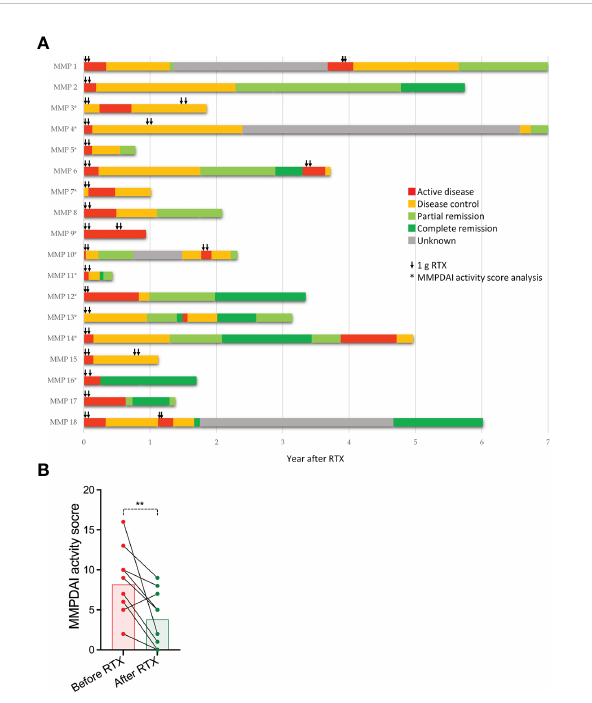
FIGURE 1 MMP disease activity before and in the years after the administration of RTX. (A) Individual course of MMP disease activity in 18 MMP patients starting with the fi rst administration of RTX. Disease was categorized as “ active disease, ” “ disease control, ” “ partial remission, ” “ complete remission, ” and “ unknown, ” following the categorization system described in the Materials and methods section. Black arrows indicate the time points of the administration of 1 g of RTX. (B) Comparison of the MMPDAI activity score at the initiation of RTX and 6 months later. Each dot represents an individual patient ( n = 11). The black lines connect the MMPDAI activity scores before and after the RTX for the individual patient. The MMPDAI before and after RTX was compared by a Wilcoxon signed-rank test ( p =